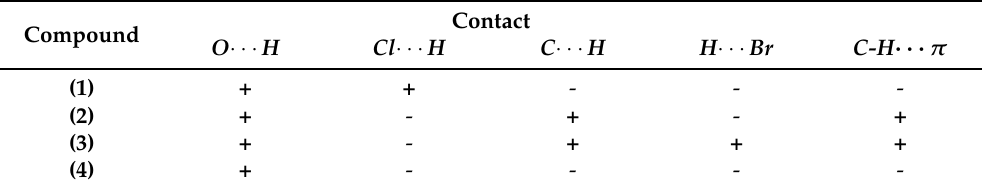
Table 1. The interatomic contacts present in the crystal structures of the investigated “proton sponges”. Symbol “+” means the presence of the contact, while “-” means the absence of the contact. Contact Compound O · · ·